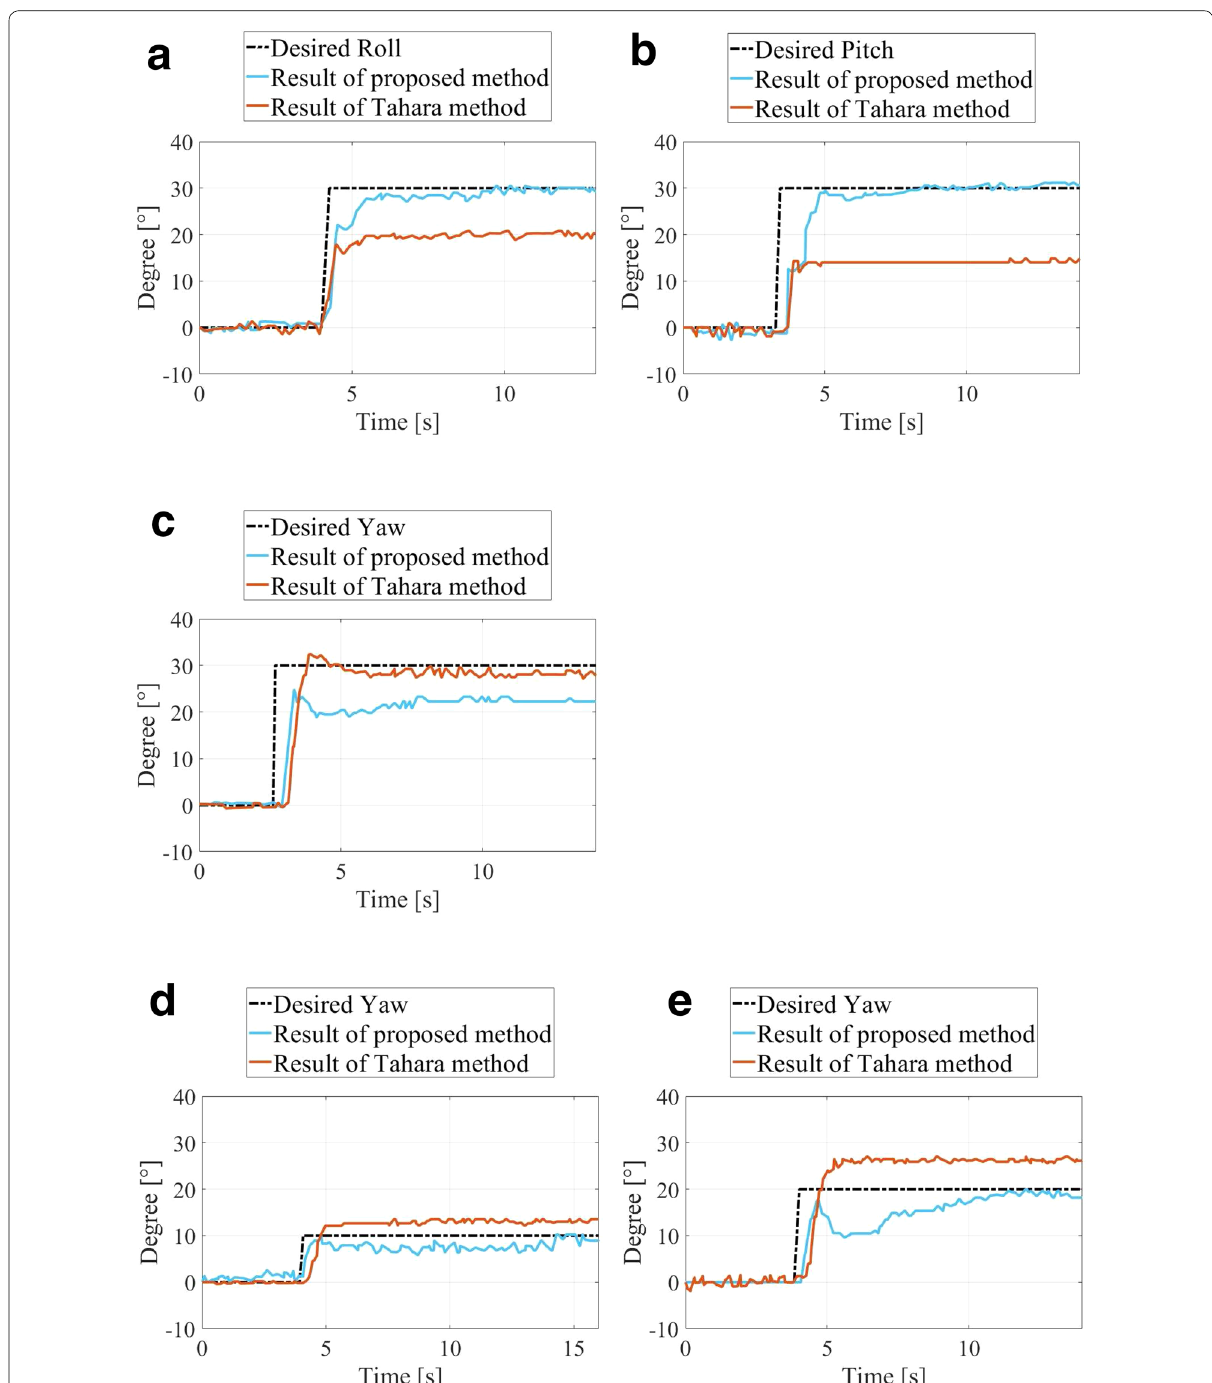
Fig. 20 Experimental results of the object orientation control: a – c comparison of the object orientation when the desired a roll, b pitch, and c yaw angles are 30 (deg), d comparison of the yaw angle of the object when the desired angle is 10 (deg), e comparison of the yaw angle of the object when the desired angle is 20